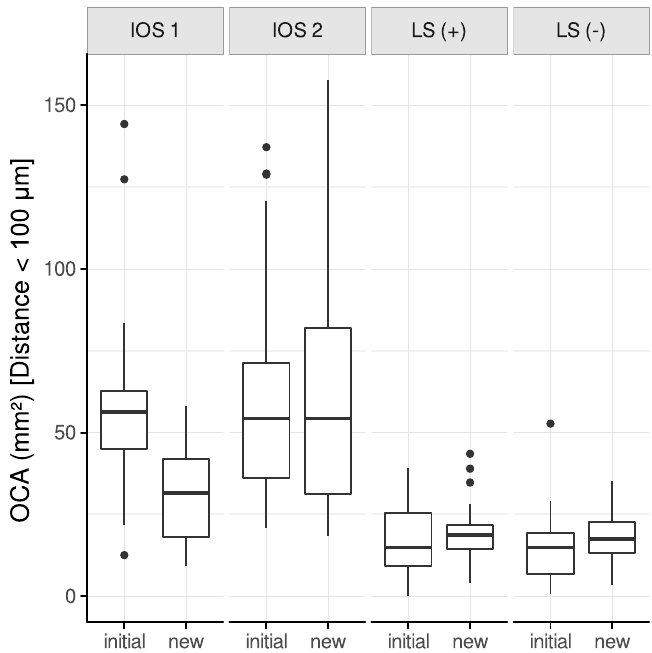
Figure 5. OCA between initial and new alignment of all modalities (partial-arch scans) restricted to a distance of 100 µ